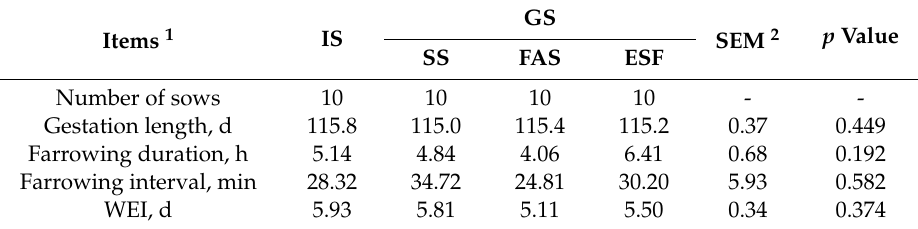
Table 3. E ff ects of individual stalls (IS) and group housing systems (GS) on gestation length, farrowing duration, and weaning-to-estrus interval (WEI) of sows.